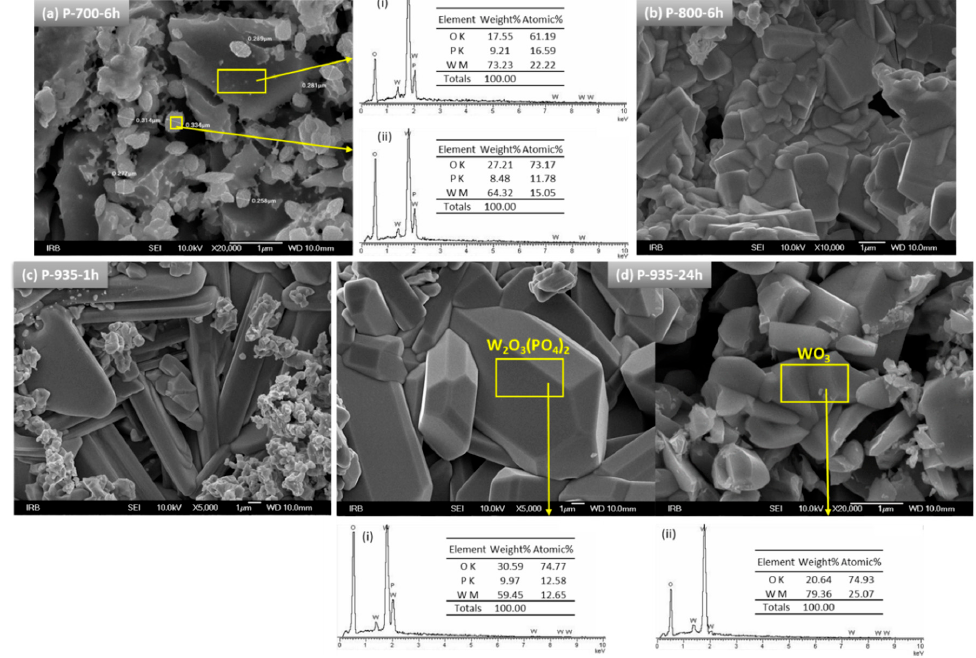
Figure 3. SEM micrographs of glass-ceramics prepared at ( a ) 700 ° C for 6 h, ( b ) 800 ° C for 6 h, ( c ) 935 ° C for 1 h, and ( d ) 935 ° C for 24 h. EDS spectra and tables with chemical composition from selected areas of the samples are shown in the insets ( i ) and ( ii